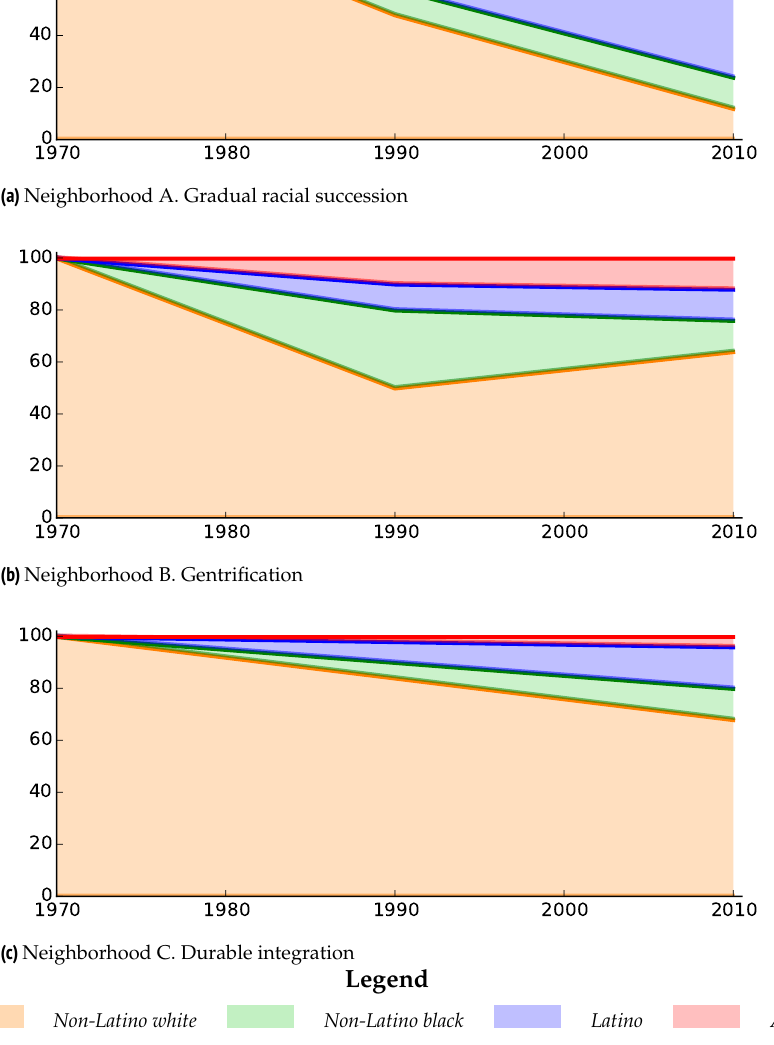
Figure 1: Hypothetical neighborhood racial change trajectories in post-Civil Rights Movement United States